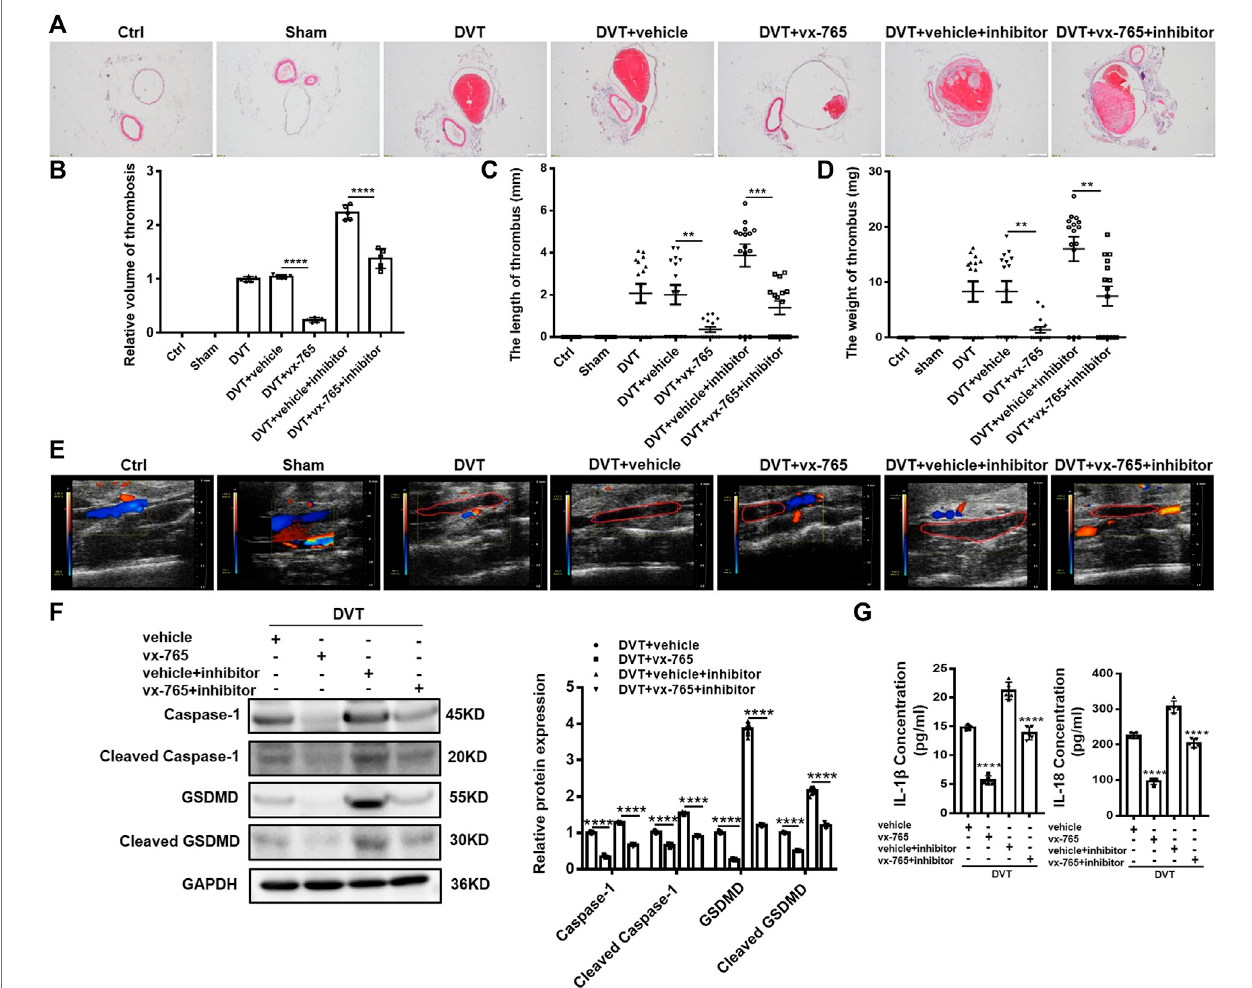
FIGURE5| Caspase-1 inhibitor(vx-765)inhibits theformationofDVT invivo . (A,B) H&EstainingofserialcrosssectionsofIVCfrom Ctrl,Sham,DVT,DVT+vehicle, DVT+vx-765, DVT+vehicle+miR-513c-5p inhibitor, DVT+vx-765+miR-513c-5p inhibitor at 48 h (magni fi cation, ×40). Scale bars = 500 μ m. (C,D) Thrombus length and weight at 48 h post-operation in the different treatment groups after the administration of caspase-1 inhibitor (vx-765) ( n = 15 in each group). (E) Representative images of thrombi in each treatment group were detected by vascular ultrasound at 48 h post-operation. (F) Caspase-1 and GSDMD protein levels were determined by WesternblotinvasculartissueofDVTanimalgroupandvx-765-treatedgroups. (G) ExpressionofIL-1 β andIL-18invasculartissueweredetectedbyELISAwithvx-765 treated each group. ** p < 0.01, *** p < 0.001, **** p < 0.0001.